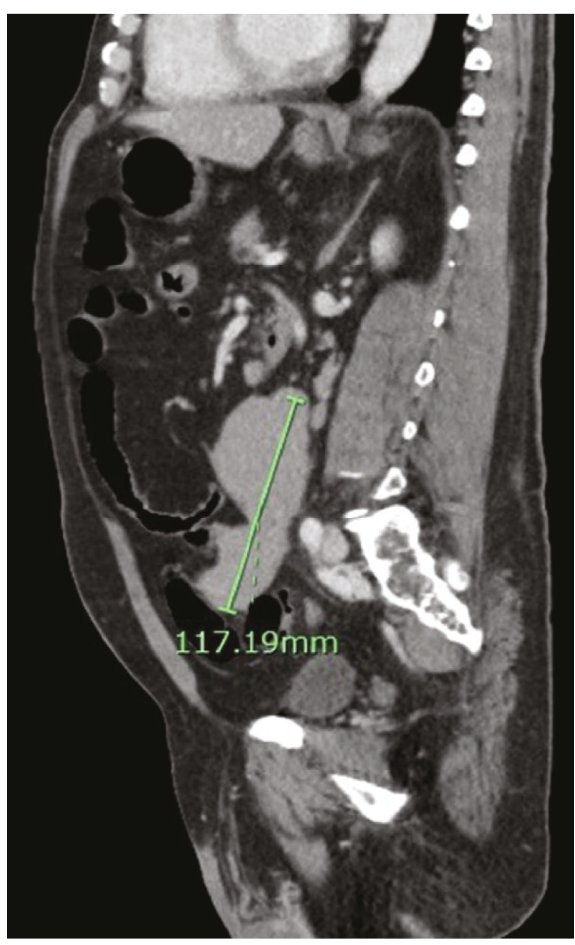
Figure 4: The same mass that was visualized in Figure 3, measured as 11.7cm on sagittal view of CT.